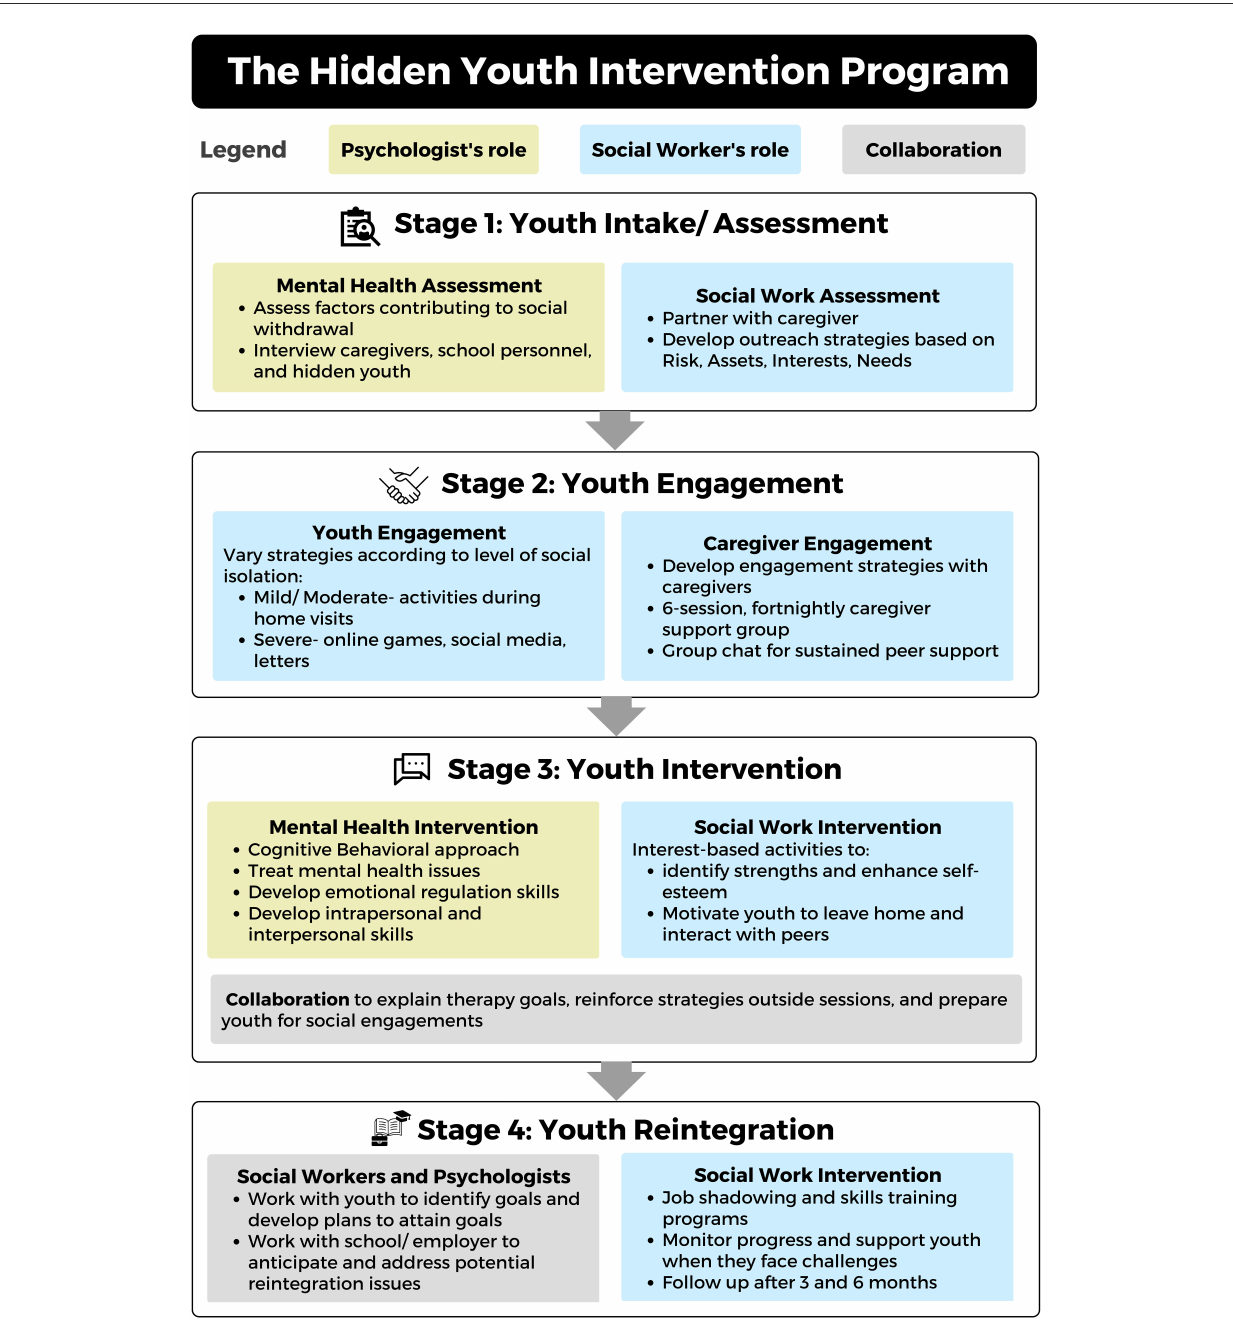
FIGURE2 The Hidden Youth Intervention Program: Stages of intervention and best